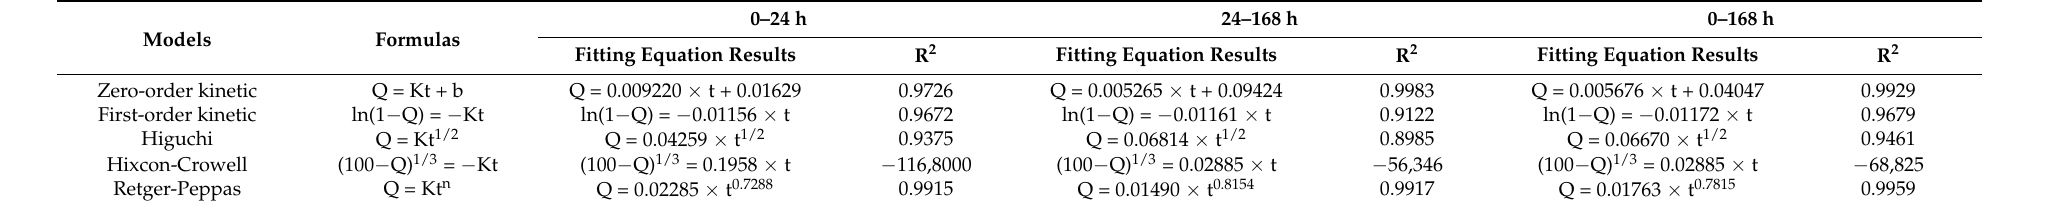
Table 1. Mathematical models fitting results of ABMs